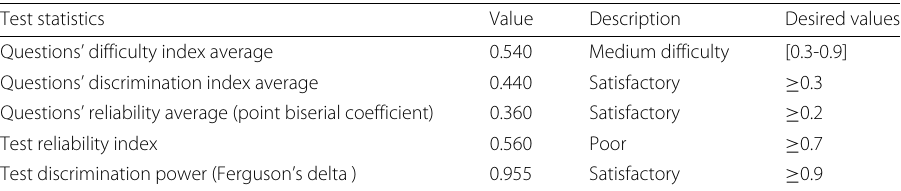
Table 17 Test-two analysis (number of students’ attempts =